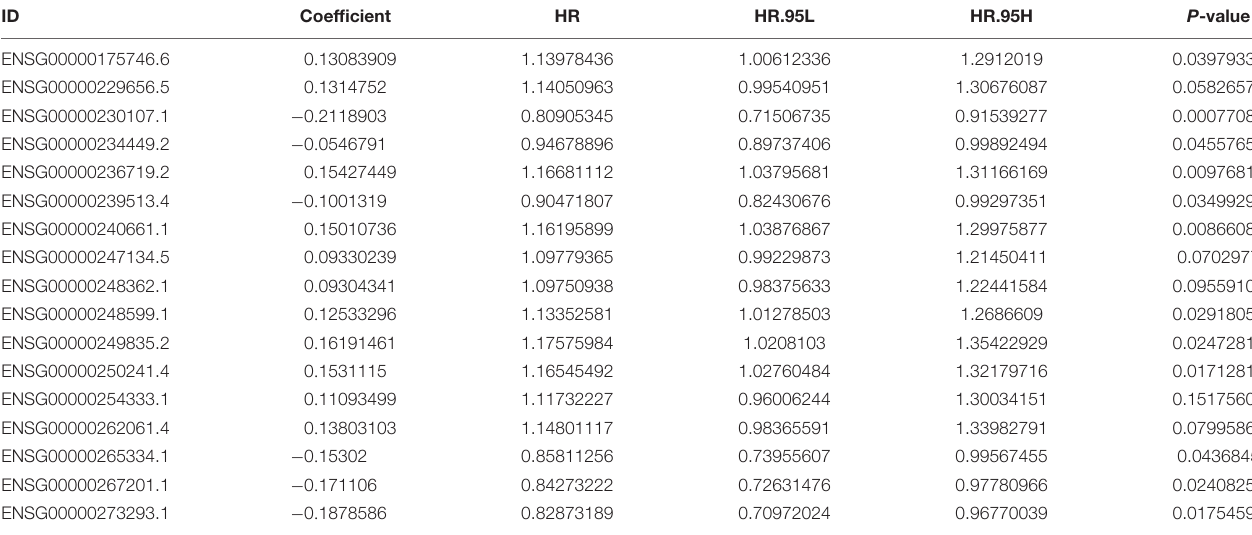
TABLE 1 | Cox regression analysis with the LASSO algorithm for the prognostic model based on 17 ferroptosis-related lncRNAs. ID Coefficient HR HR.95L HR.95H